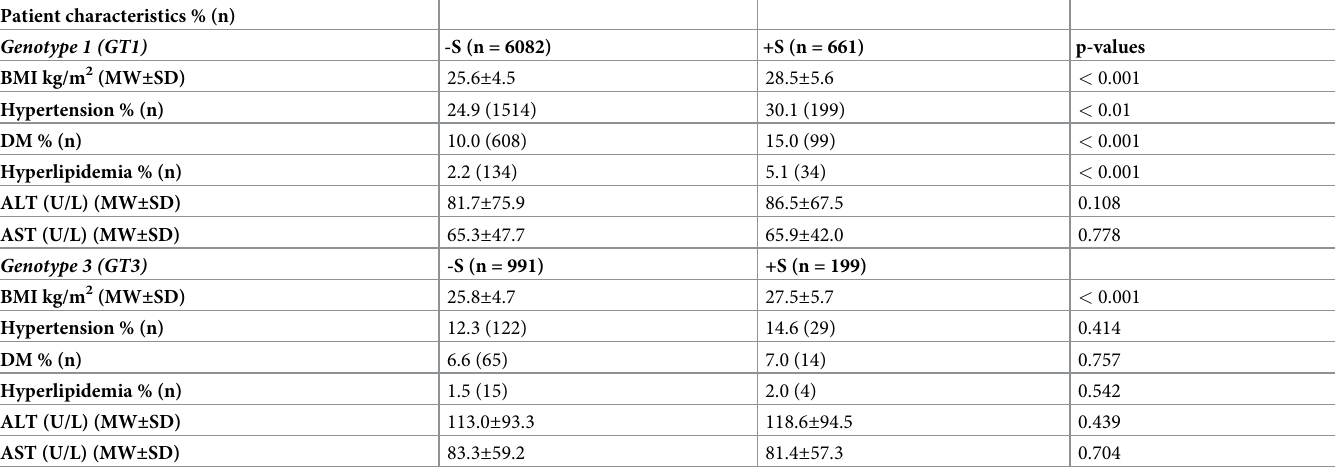
Table 2. Baseline characteristics of HCV GT 1 and GT 3 patients.